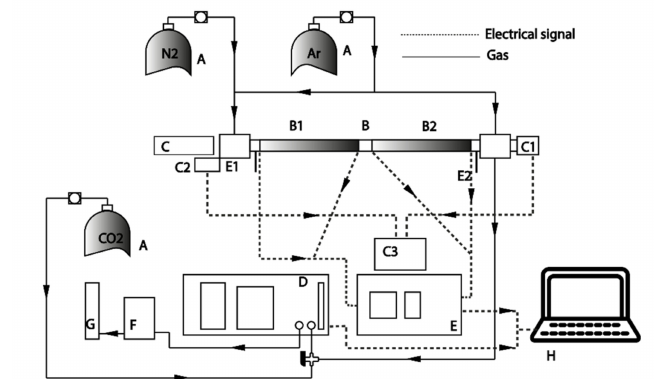
Figure 2. Scheme of the thermo-optical system used: modified from [42]. A—gas bottle; B—quartz oven; B1 and B2—heating zones; C—laser; C1—detector; C2—chopper; C3—amplifier; D—nondispersive infrared spectrophotometer; E—temperature controller; E1 and E2—thermocouplers; F—mass flow meter; G—rotameter; and